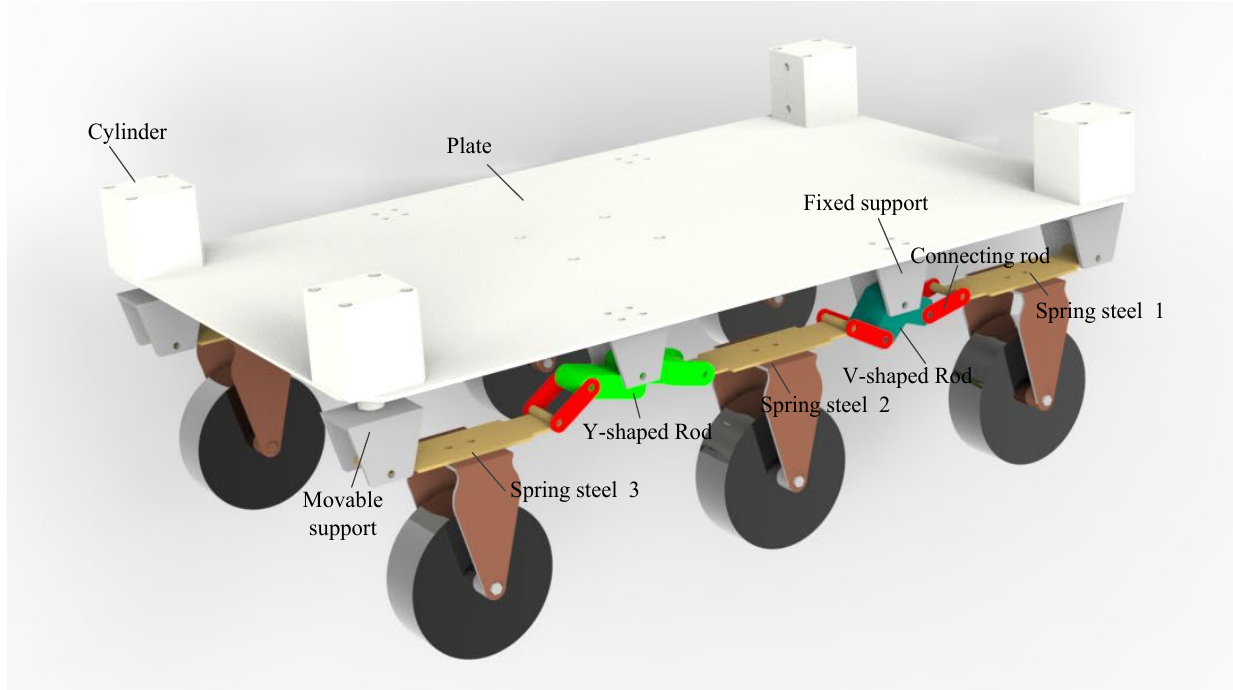
Figure 4. 3D models of mobile chassis for inspection robot.